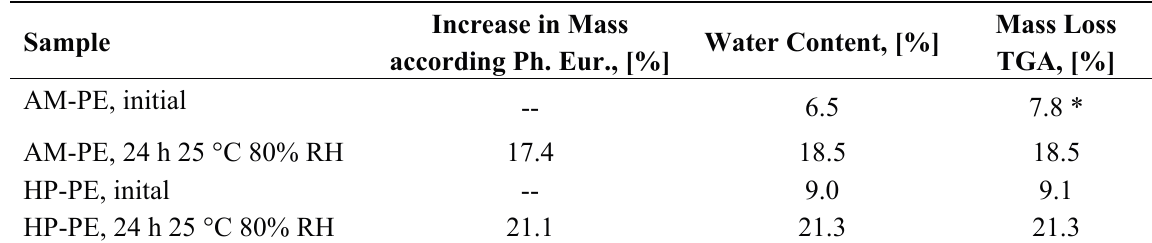
Table 2. Results of hygroscopicity tests.